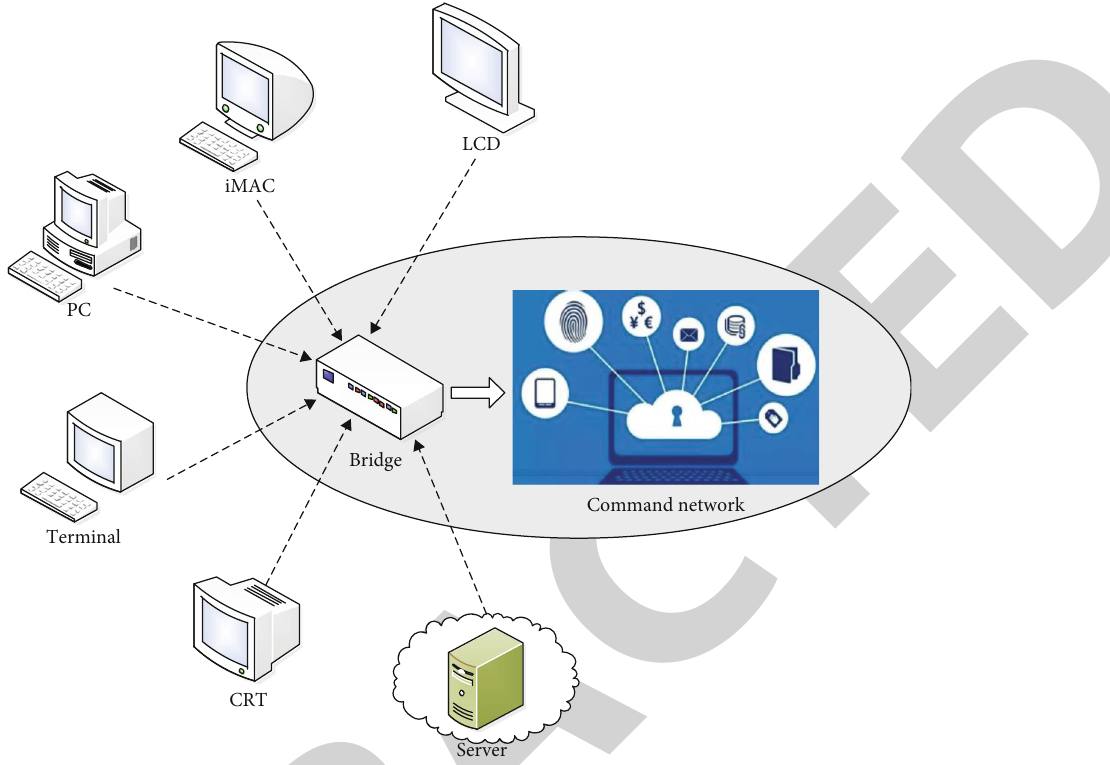
Figure 1: The working principle of information fusion